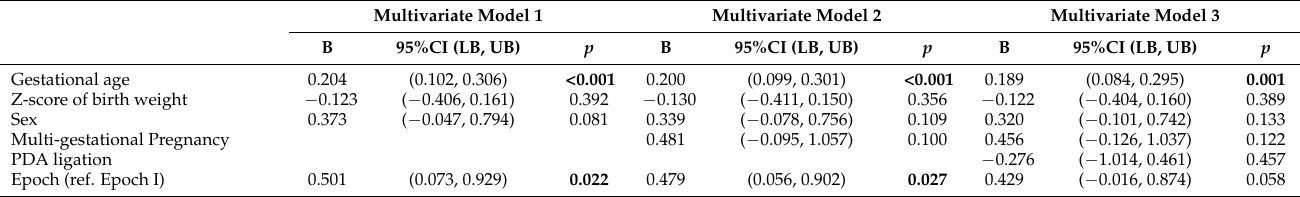
Table 3. Dependence of ∆ z-score of body weight at term equivalent age on clinical variables: multivariate